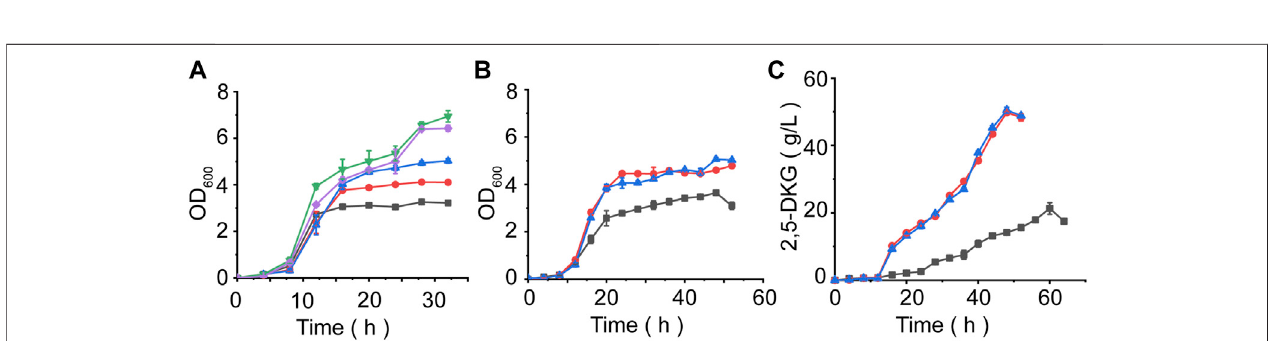
FIGURE5| Evaluatingfermentationperformancesunderdifferentconditions. (A) G.oxydans ATCC9937growthcurveatdifferentD-glucoseconcentrations.Black =5 g/LD-glucose.Red=10 g/LD-glucose.Blue=15 g/LD-glucose.Green=20 g/LD-glucose.Purple=25 g/LD-glucose. (B) Theeffectofdifferentfeedingmethods on OD 600 values. (C) Time course of 2,5-DKG production using different feeding methods. Black = control, initial D-glucose concentration = 100 g/L. Blue: After initial glucose levels were consumed, further glucose was added in a constant-rate feeding mode. Red: Further glucose was added in a single-dose feed-batch mode after initial glucose quantities were consumed.